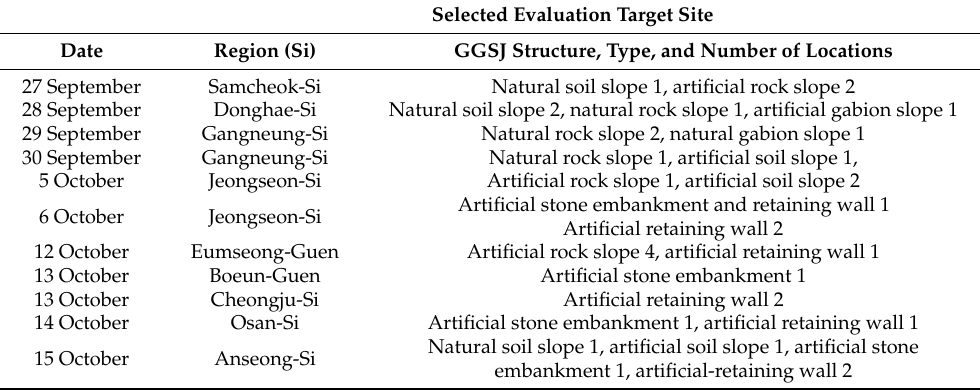
Table 1. Dates and times of site evaluations along with information about the locations, structures, and types of GGSJs.